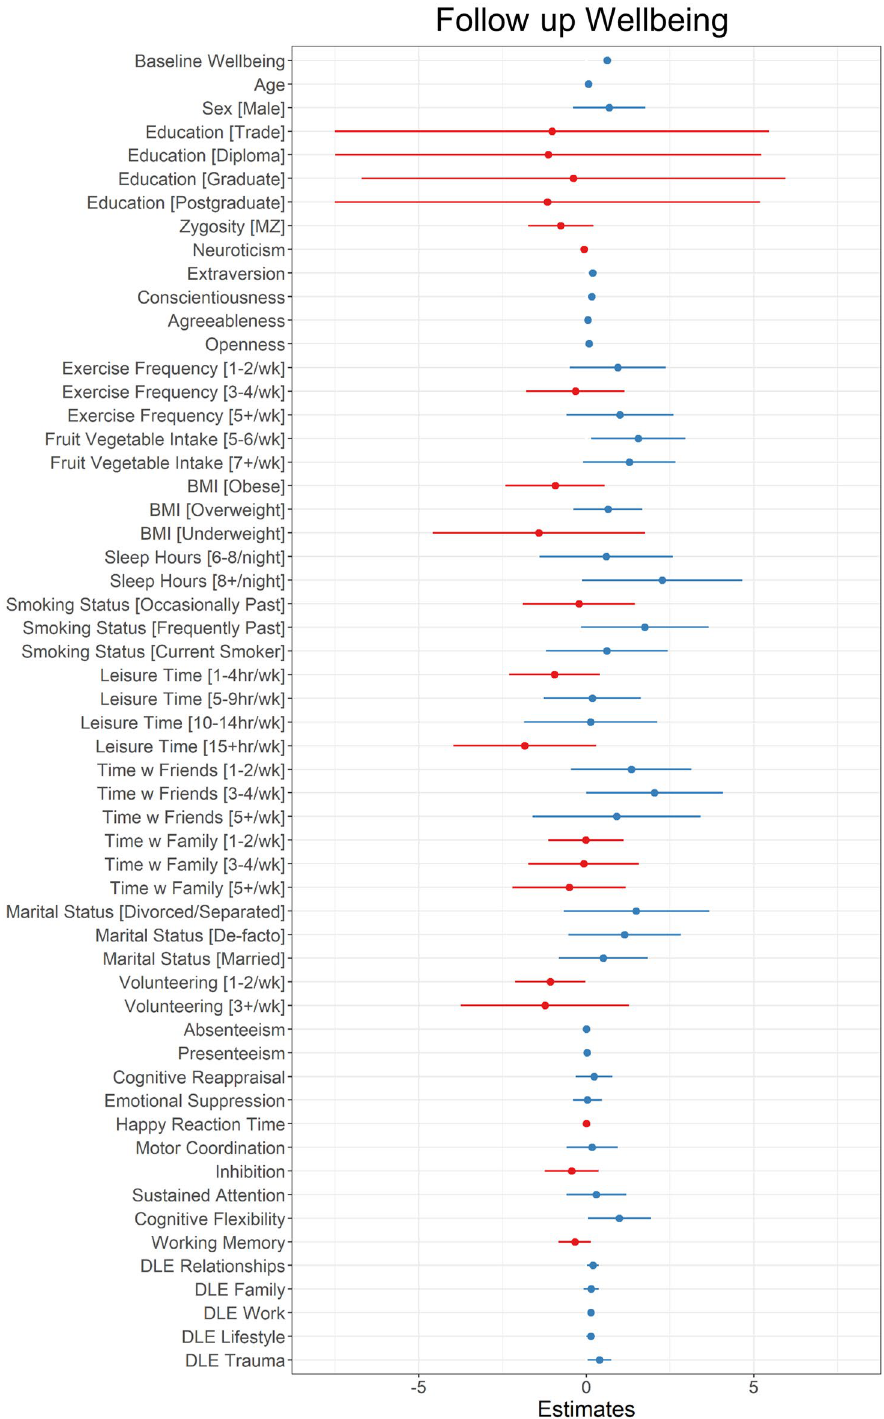
Figure 4. Unstandardised coefficients and 95% confidence interval limits for the final repeated measures model. Blue lines indicate positive coefficients and red lines indicate negative coefficients. Education reference level is High School education; Zygosity reference level is DZ, Marital Status reference level is Single, BMI reference level is Healthy, all other ordinal variable reference levels are “Never” or the lowest level measured. N = 1017, n for ordinal variables provided in Table